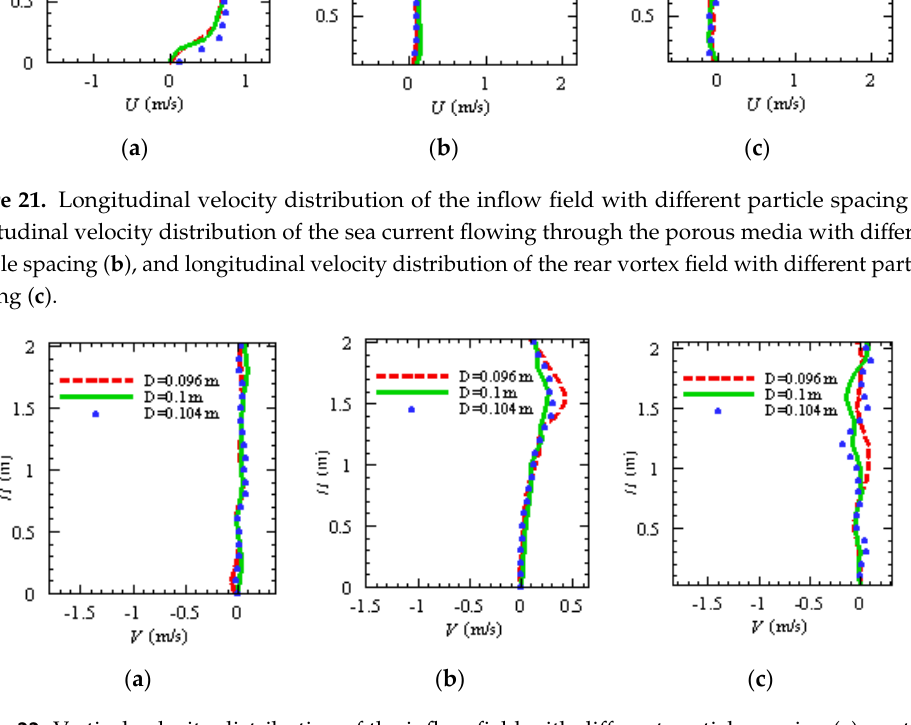
Figure 22. Vertical velocity distribution of the inflow field with different particle spacing ( a ), vertical velocity distribution of the sea current flowing through the porous media with different particle spacing ( b ), and vertical velocity distribution of the rear vortex field with different particle spacing ( c ).